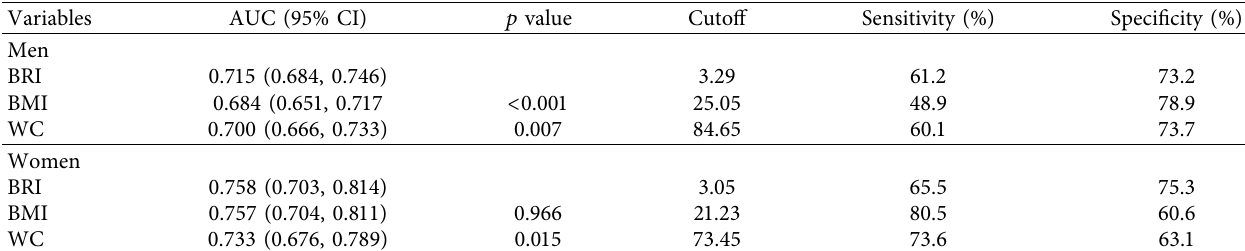
Figure 2: ROC curves for BRI, BMI, and WC in men (a) and women (b) in the NAGALA study. AUC of BRI, BMI, and WC to identify participants with T2DM according to sex. BRI, body roundness index; BMI, body mass index; WC, waist circumference (cm); AUC, area under the curve. Table 4: ROC analysis for BRI in predicting type 2 diabetes in the NAGALA